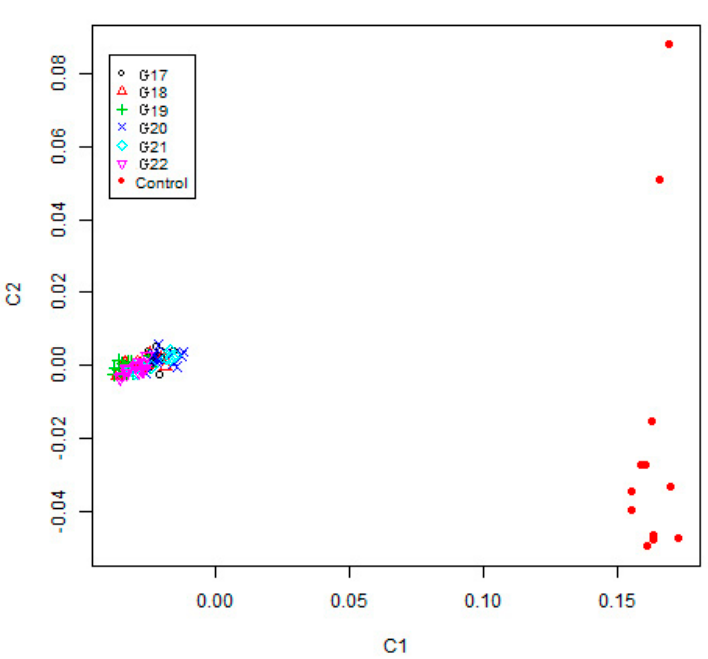
Figure 2. Multidimensional scaling analysis of the 108 individuals including 96 inbred strain and 12 non-inbred individuals. This analysis is based on genome-wide identity-by-state pairwise distances calculated with the PLINK software using 7714 linkage disequilibrium (LD)-filtered single nucleotide polymorphisms (SNPs). C1: first component; C2: second component.